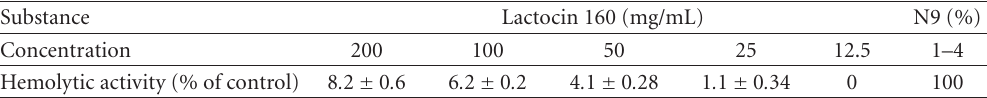
Table 3: Hemolytic activity of lactocin